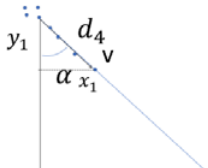
Fig. 3. Vehicle turning state. (cid:3)